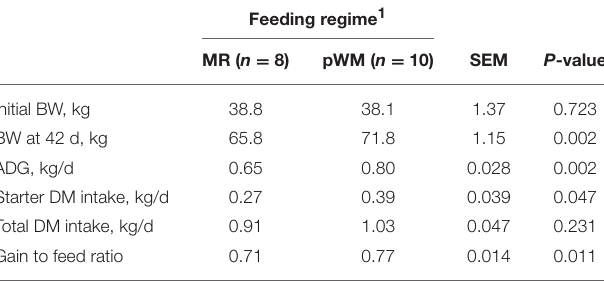
TABLE 1 | Effect of milk feeding regime on growth performance and starter feed intake in dairy calves. Feeding regime